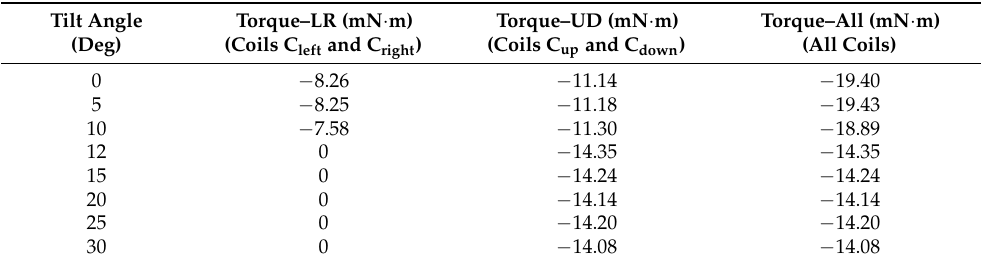
Table 4. The values of the improved torque with respect to the tilt angle along the X -axis for the Z -axis. Tilt Angle